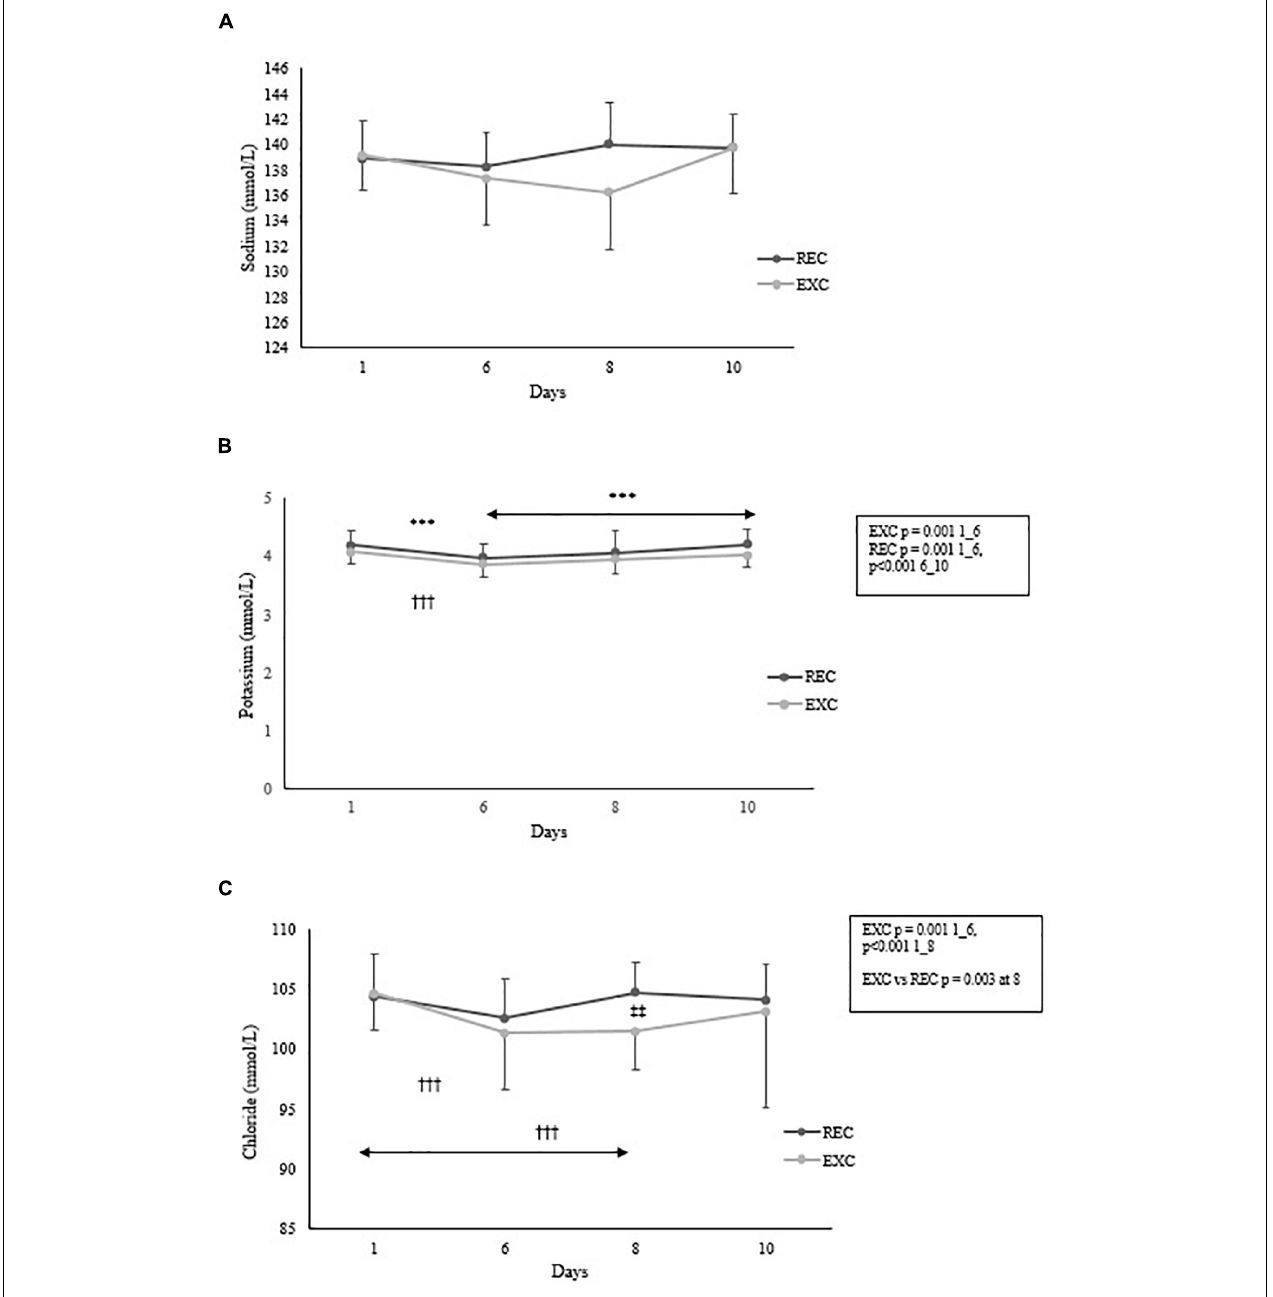
FIGURE 4 | Changes in (A) sodium (B) potassium and (C) chloride concentration within and between the REC and EXC groups. In the REC group n = 26, 22, 22, 20 and in the EXC group n = 42, 26, 27, 25 for days 1, 6, 8, 10 respectively. ∗ REC, † EXC, and ‡ Between groups. ‡‡ p < 0.01; ∗∗∗ , ††† p <